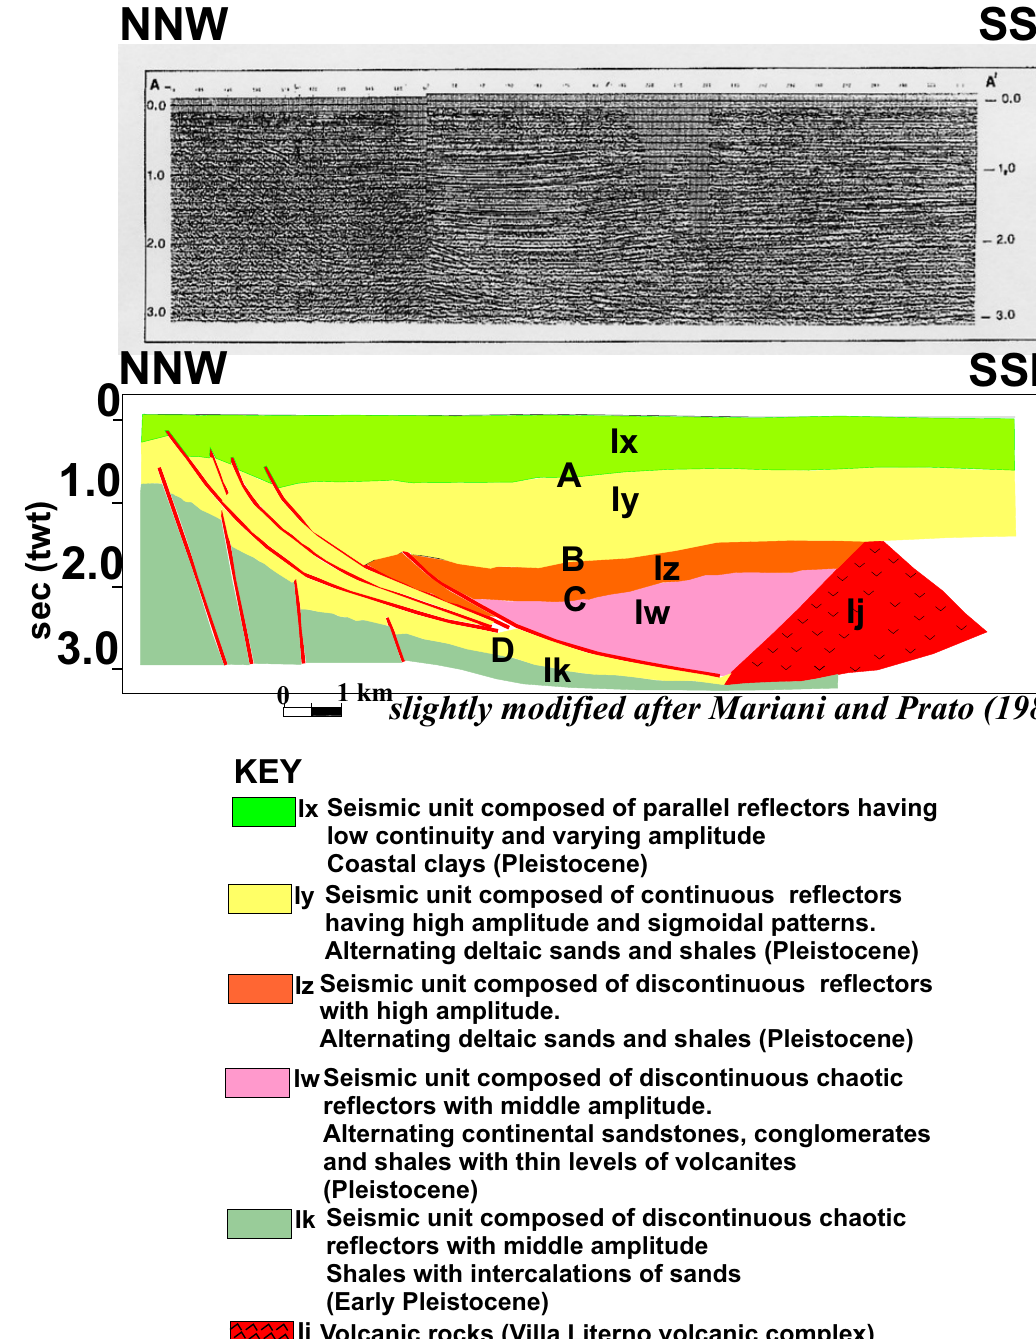
Figure 13. Interpreted seismic section onshore in the Volturno Basin (modified after Mariani and Prato [1988]). Note the occurrence of four main onshore seismic sequences, that are correlated with the offshore seismic sequences identified based on the seismo-stratigraphic analysis of the Sister4_2 seismic profile (see also the Figures 6 and